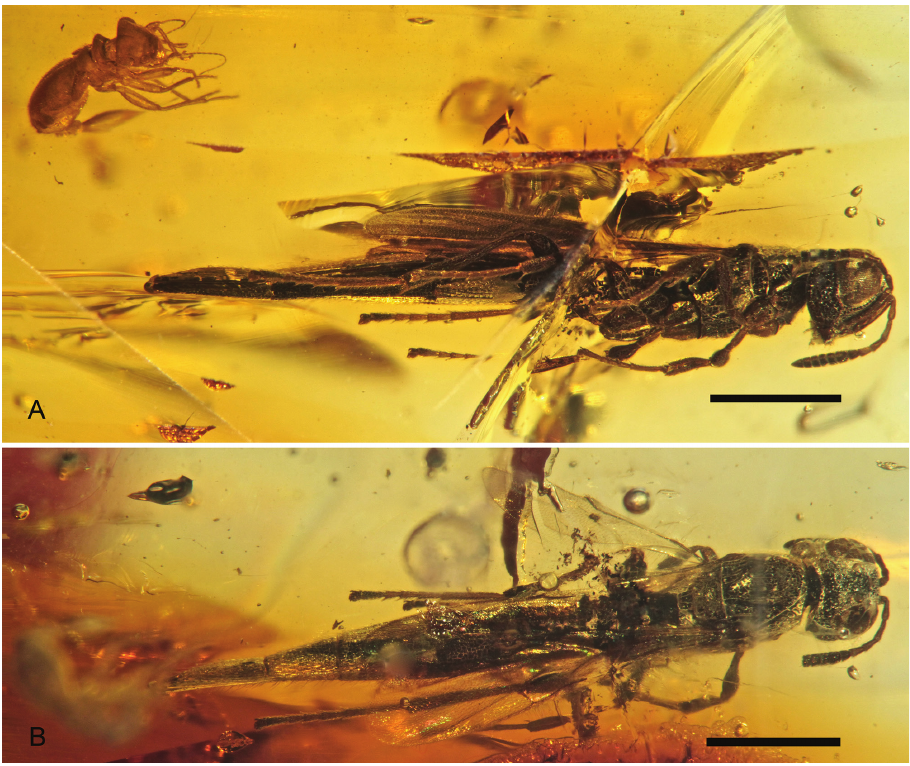
Figure 1. Macroteleia yaguarum Perrichot & Engel, sp. n., holotype MUSM-A-2006-4a, female A Right lateral habitus B Dorsal habitus. Scale bars: 1